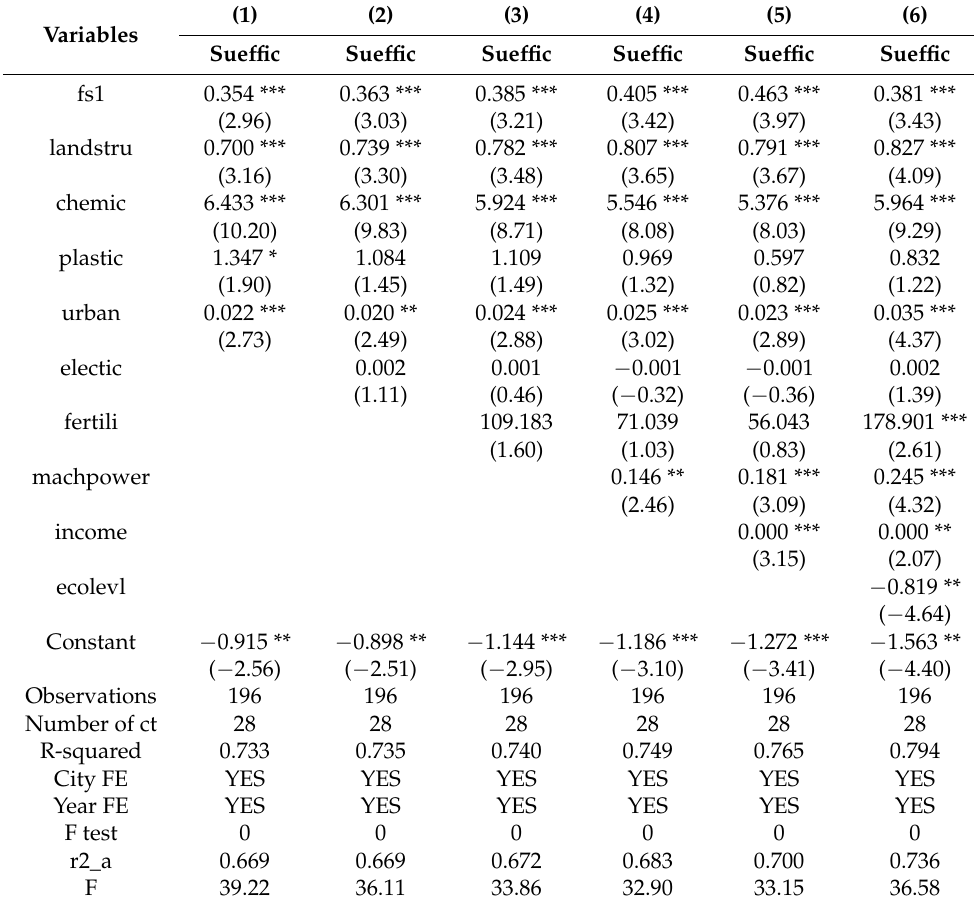
Table 9. Results of the two-way fixed-effect